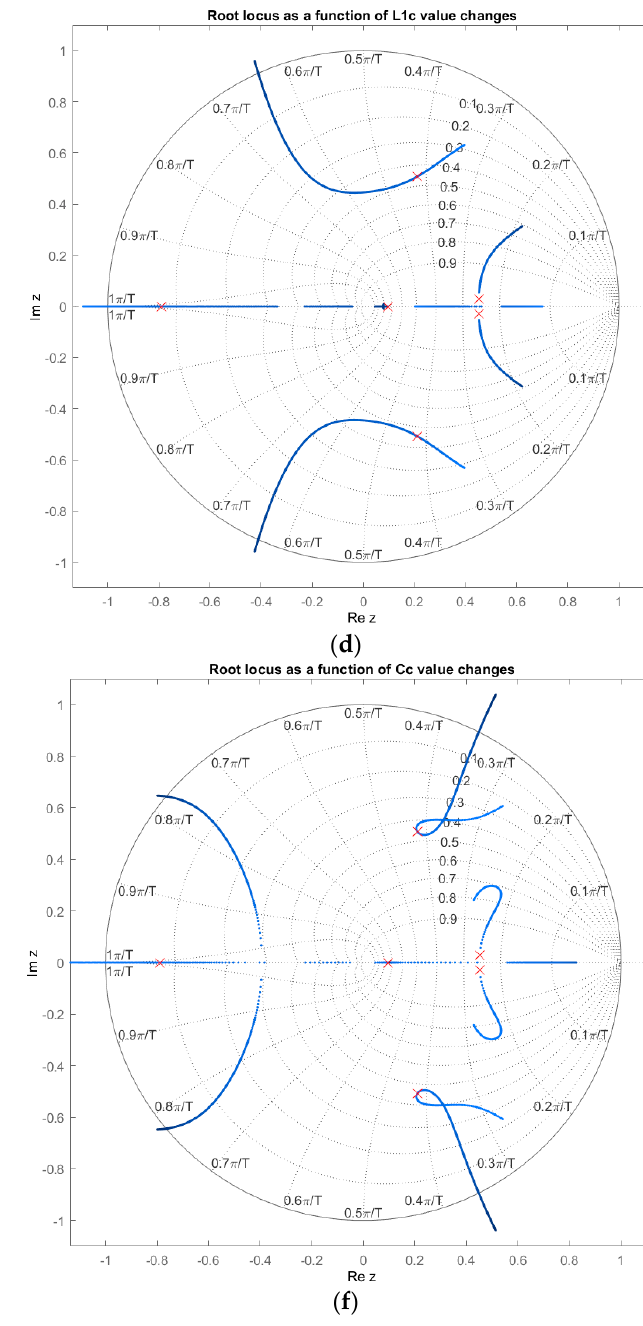
Figure 9. Results of the APF closed-loop control system stability analysis. Root locus as a function of the following parameter value changes: K p ( a ), K i ( b ), T s ( c ), L 1c ( d ), L 2c ( e ), C c ( f ).